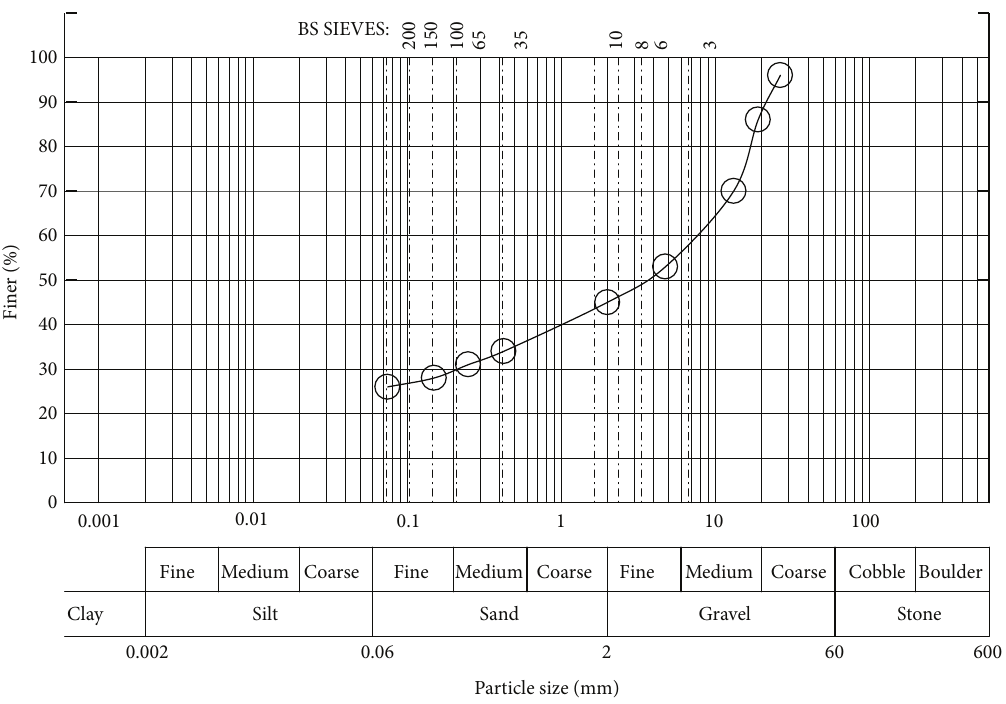
Figure 3: The grading curve for the weathered dolerite aggregate (WDA) sample.